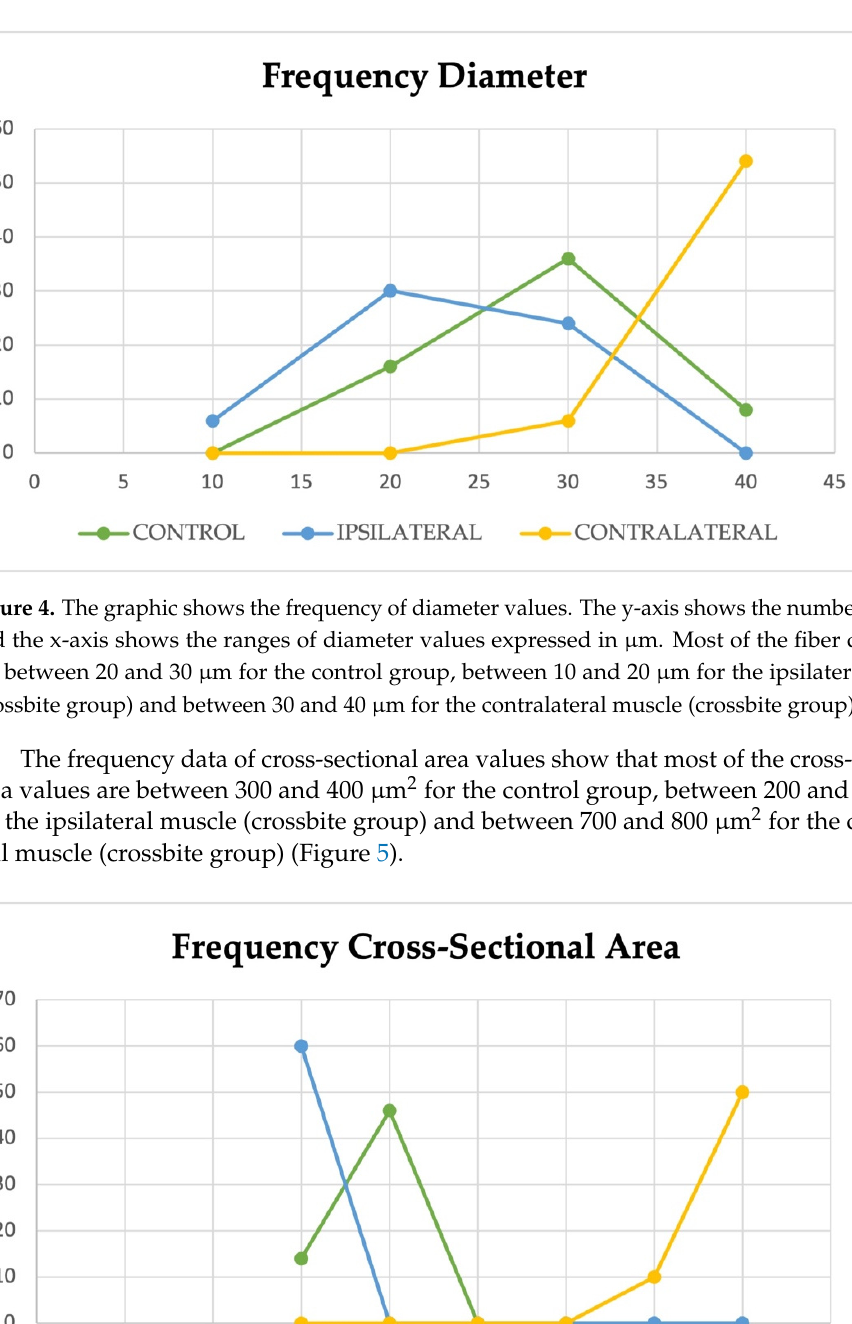
Figure 6. Compound panel of Gaussian curves showing the normal distribution of fiber diameters and cross-sectional area values for the control and for both ipsilateral and contralateral muscles of the crossbite group. 5. Conclusions During unilateral posterior crossbite, the first morphological changes seems to involve the contralateral masseter muscle, which undergoes hypertrophy, as evidenced by the statistically significant increase in their fiber diameters when compared to both control and ipsilateral muscles. On this basis, we can suggest that contralateral muscle hypertrophy is a response to the higher workload this muscle it is subjected to, in order to compensate for the already demonstrated low activity of the affected muscle [1]. Author Contributions: Data Curation, G.C. and A.C.; Formal Analysis, G.P.; Founding acquisition, M.M.; Investigation, M.M. and G.A.; Methodology, G.V. and G.S.; Resources, M.R.A.; Supervision, G.C. and M.P.; Validation, M.P. and A.C.; Visualization, M.R.A. and G.P.; Writing—Original draft,